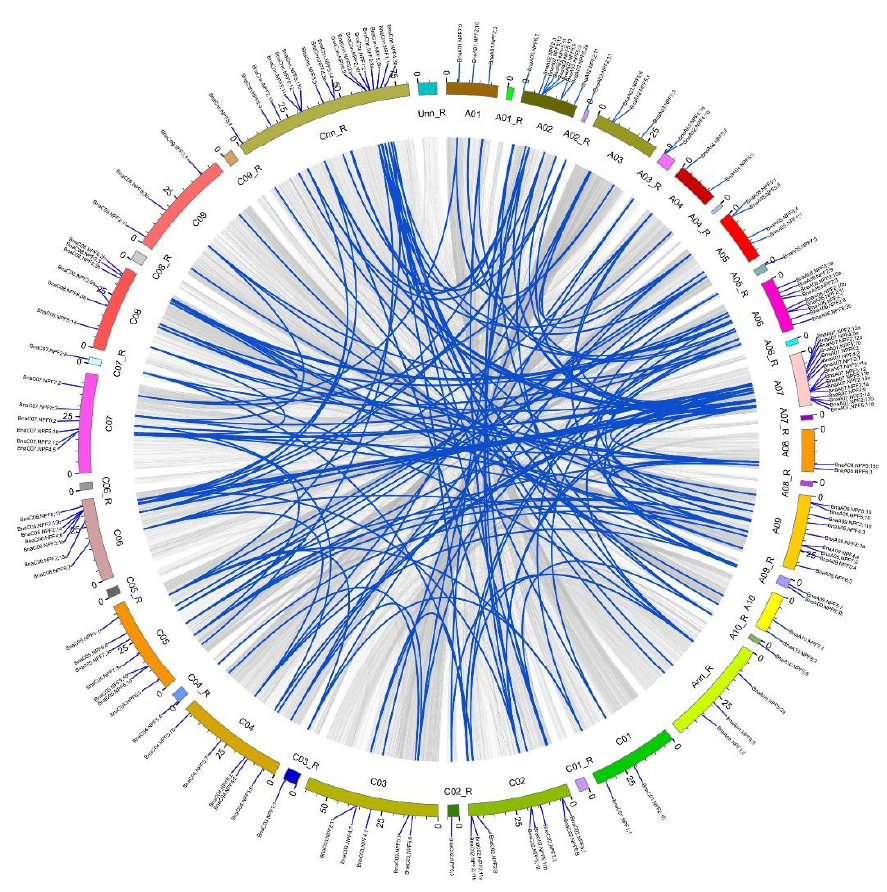
Figure 3. Schematic representations for the chromosomal distribution and interchromosomal relationships of rapeseed NPF genes. Gray lines in the background indicate all syntenic blocks in the Brassica napus genome, and the blue lines indicate syntenic NPF gene pairs. The chromosome number is indicated at the bottom of each chromosome. R, random.